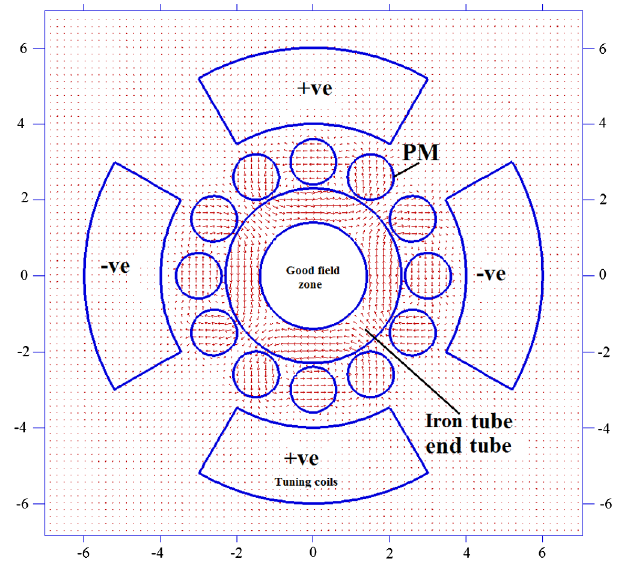
FIG. 11. Field lines obtained from the 2D simulation in the presence of an iron tube at the bore of a quadrupole magnet are shown in the figure. Shielding of the magnetic field in the good field zone is evident.